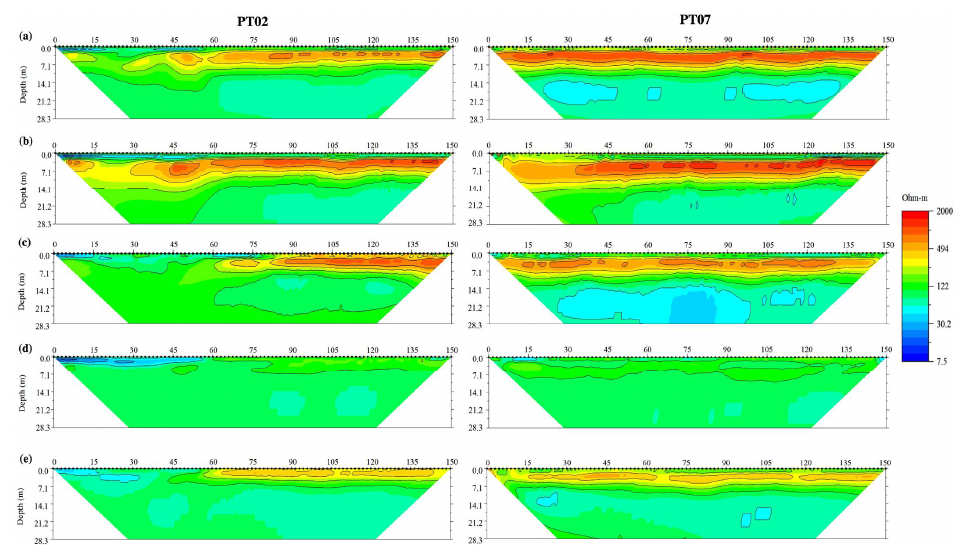
Figure 9. Time-lapse inverted resistivity models of PT02 and PT07 sites for ( a ) February, ( b ) April, ( c ) July, ( d ) September, and ( e ) November.